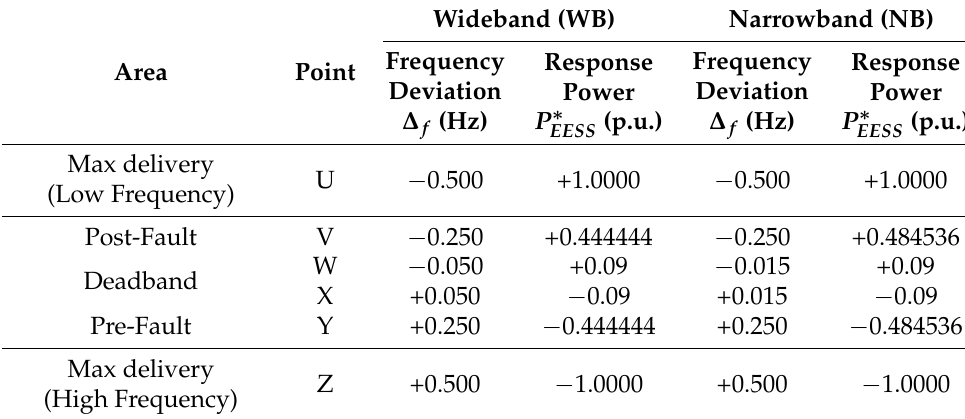
Table 1. EFR reference values for both the WB and NB